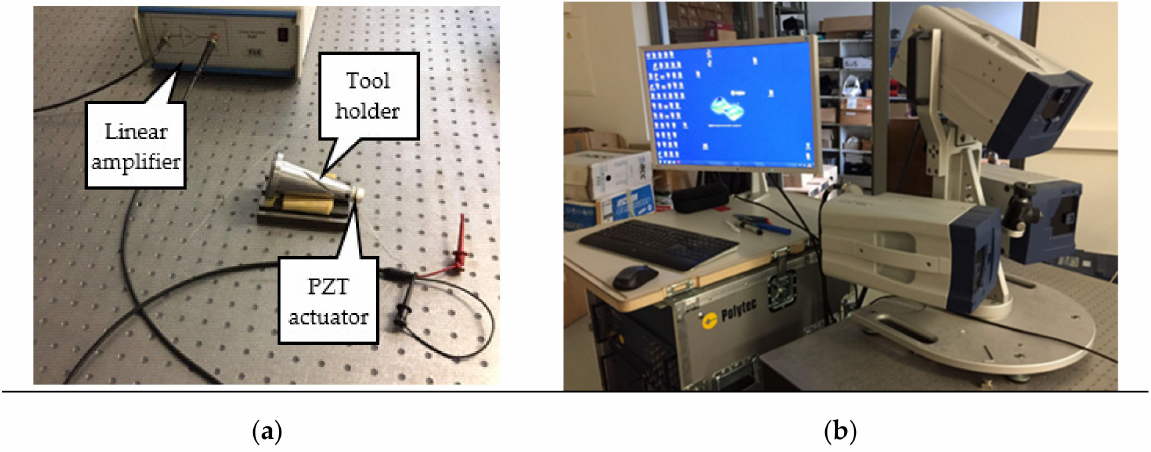
Figure 11. Actual experimental set-up of the vibration response of the tool holder with and without helical slots. ( a )—view of the tool holder with a fixed piezoelectric actuator and a linear amplifier P200 (FLC Electronics AB, Partille, Sweden), ( b )—a view of the Polytec PSV-500 3D laser doppler vibrometer-scanner (Polytec GmbH, Widbronn,